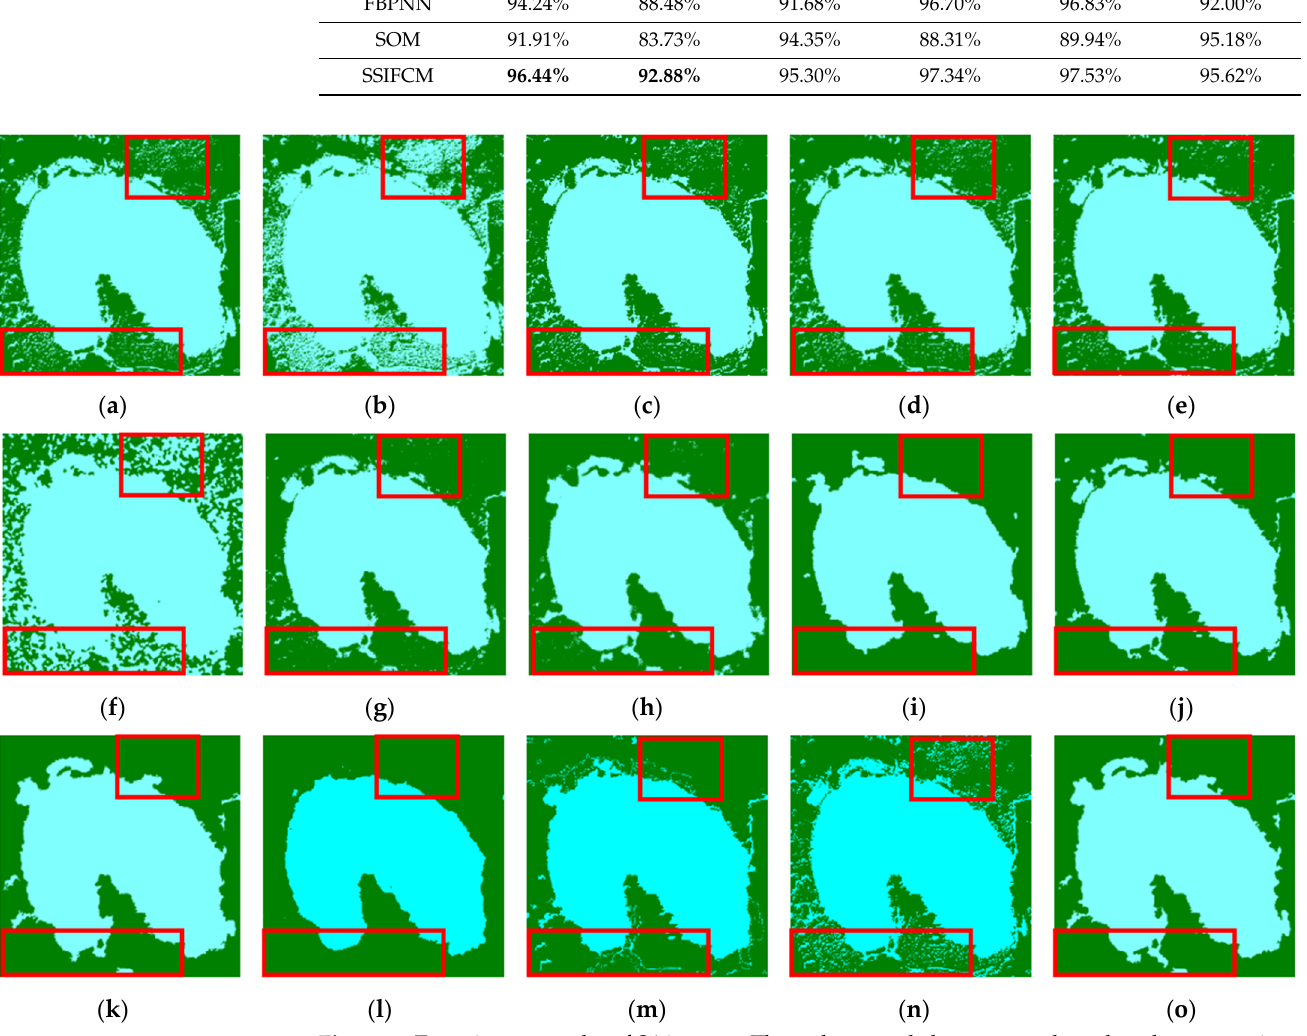
Figure 7. Experiment results of S4 images. The red rectangle boxes are selected as the comparison areas. ( a ) S4 K-means, ( b ) S4 ISODATA, ( c ) S4 FCM, ( d ) S4 IFCM, ( e ) S4 FLICM, ( f ) S4 HMRF-FCM, ( g ) S4 FCM_S, ( h ) S4 FCM-SICM, ( i ) S4 SFFCM, ( j ) S4 FRFCM, ( k ) S4 SPFCM, ( l ) S4 SBPNN, ( m ) S4 FBPNN, ( n ) S4 SOM, and ( o ) S4 Table 8. Evaluation of S4 image classification results.